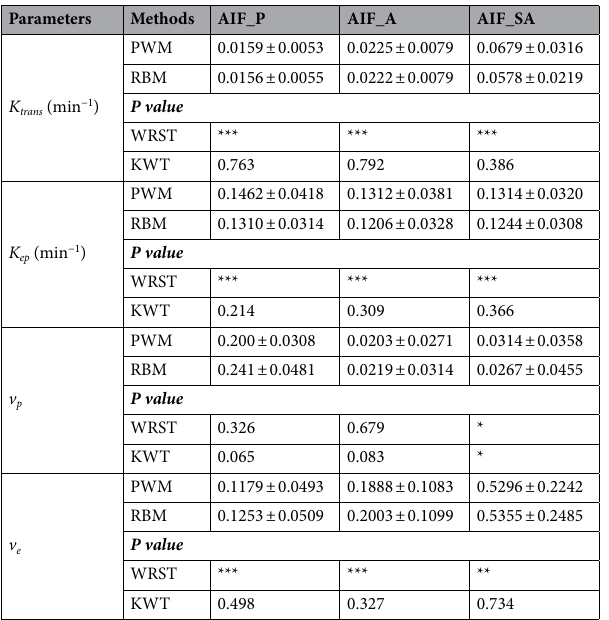
Table 1. Comparison of perfusion parameters between PWM and RBM regarding different AIFs. * P < 0.05, ** P < 0.01, *** P <